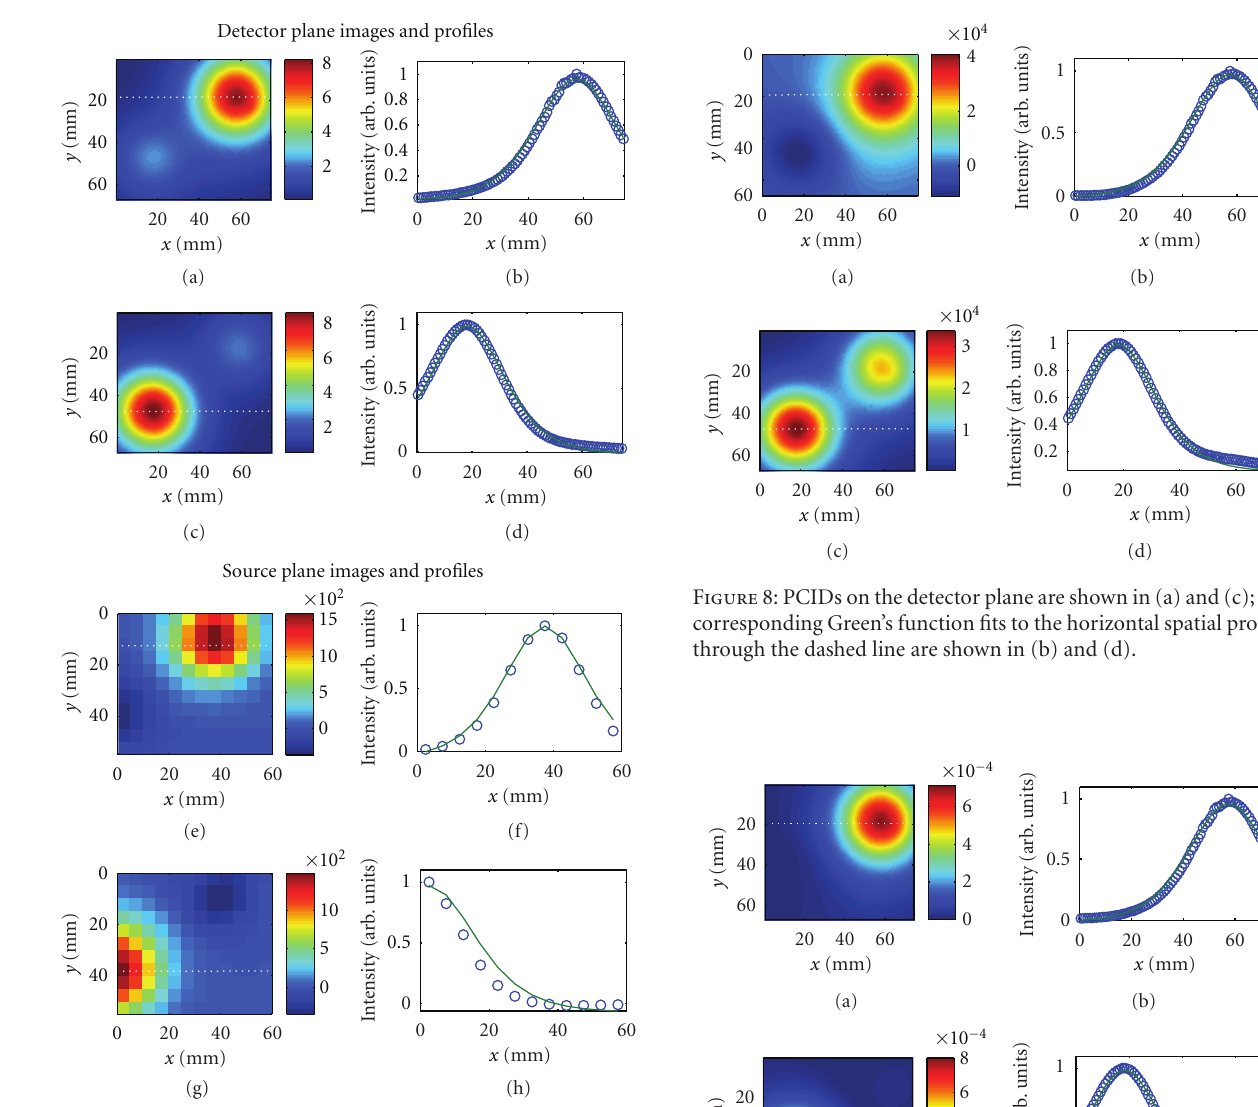
Figure 7: ICA-generated ICIDs on the detector plane are shown in (a) and (c); corresponding Green’s function fits to the horizontal spatial profiles through the dashed lines are shown in (b) and (d). ICIDs on the source plane are shown in (e) and (g); corresponding Green’s function fits to the horizontal spatial profiles through the dashed line are shown in (f) and (h).